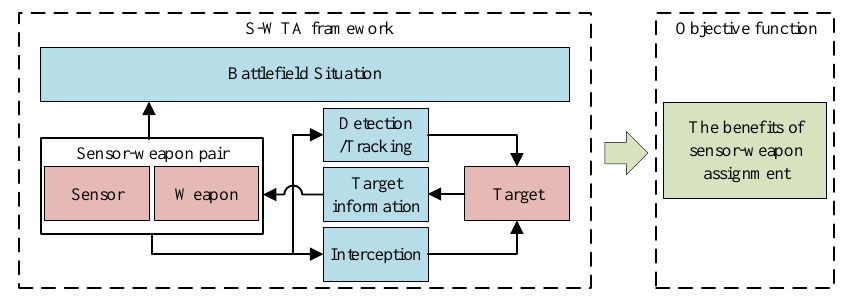
Figure 2. The dependent S-WTA